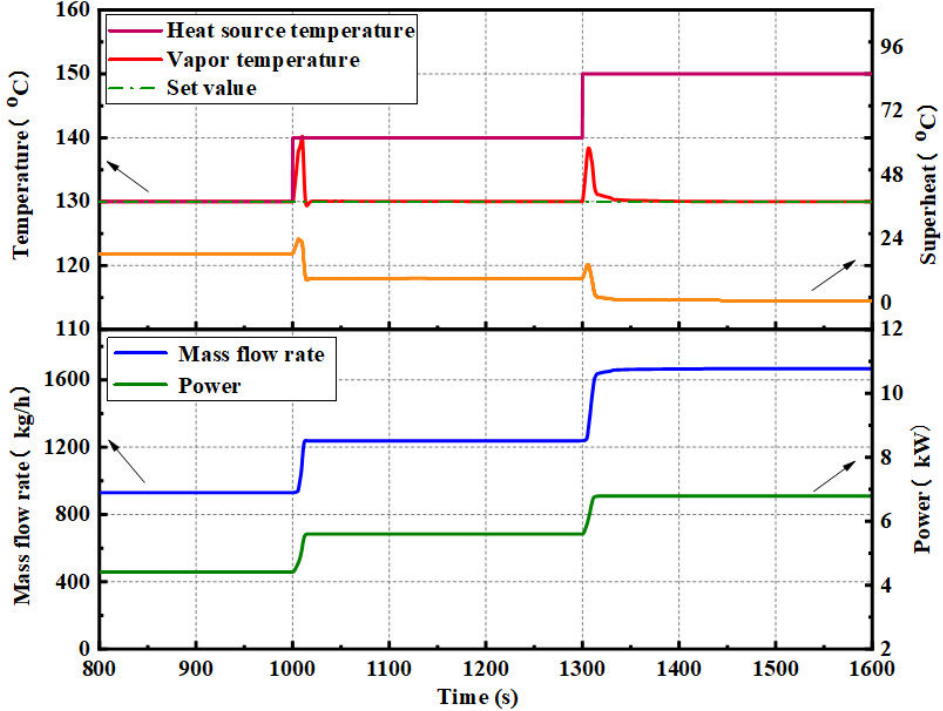
Figure 9. Dynamic response of key operating parameters under the CVT